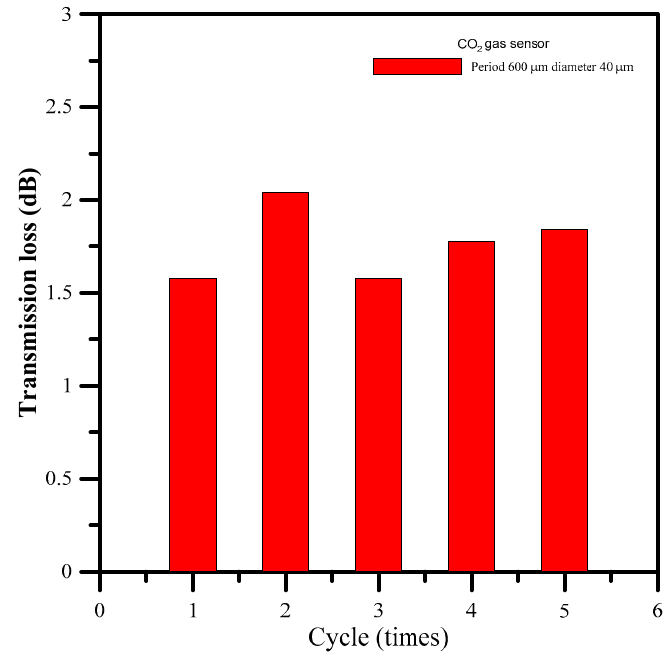
Figure 6. Changes in transmission loss for the CO 2 gas sensor.